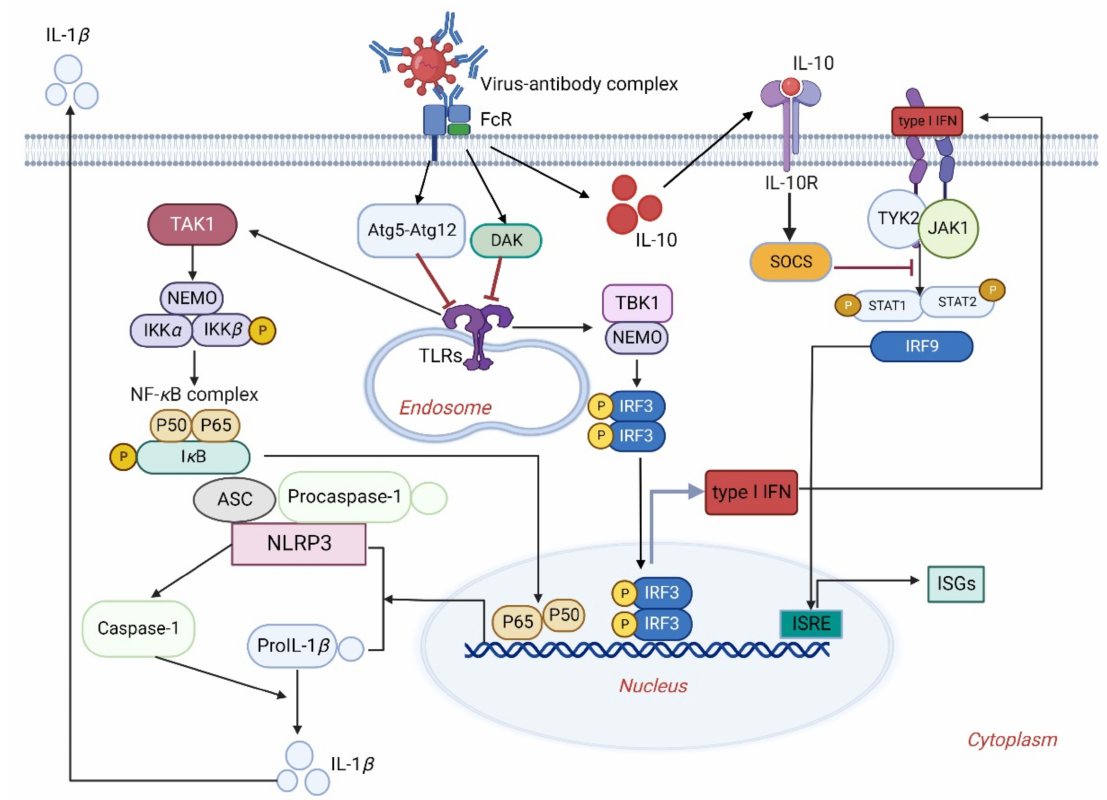
Figure 2. The distinct innate immune response of host cells under the ADE of viral infections. The virus–antibody complex binds to and activates FcRs that upregulate dihydroacetone kinase (DAK) and autophagy-related gene 5 and 12 (Atg5-Atg12 complex); it subsequently inhibits the TLRs activation and signaling pathway. Meanwhile, IL-10 activates the suppressor of cytokine signaling (SOCS) and then inhibits the Janus kinase-signal transducer and the activator of transcription (JAK- STAT)-specific pathway, resulting in the suppression of the interferon-mediated antiviral responses of host cells. On the other hand, release of the viral genome into the cytoplasm leads to the activation of TLRs, which subsequently increases IL-1 β release by activating the NF- κ B signaling